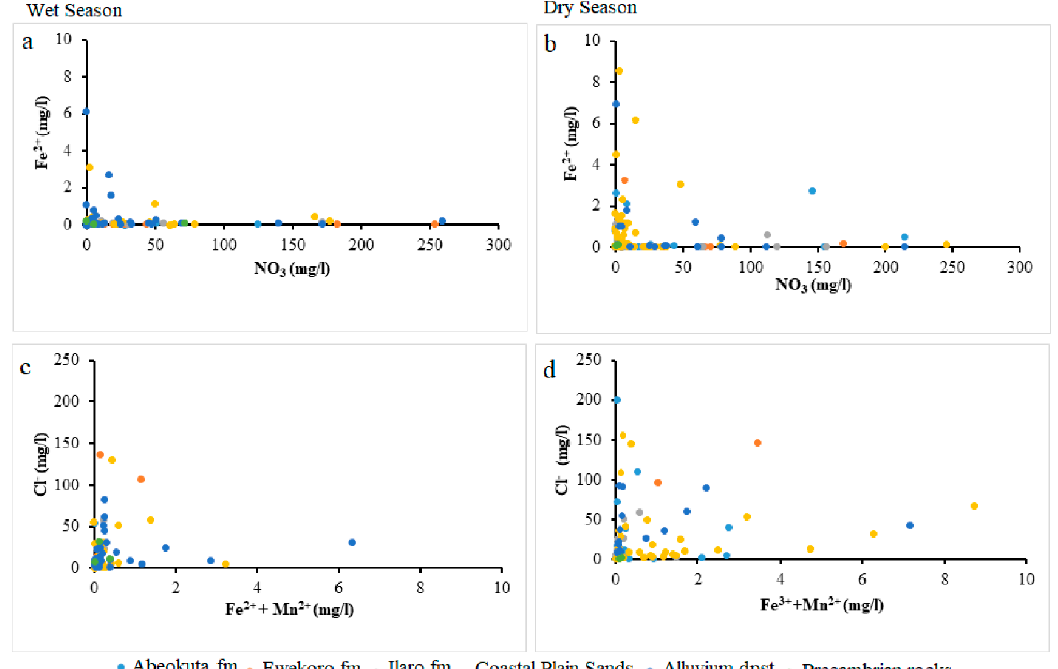
Figure 9. Scatter plots NO 3 against Fe 2 + ( a ) wet season ( b ) dry season and Fe 2 + + Mn 2 + against Cl − ( c ) wet season ( d ) dry season.